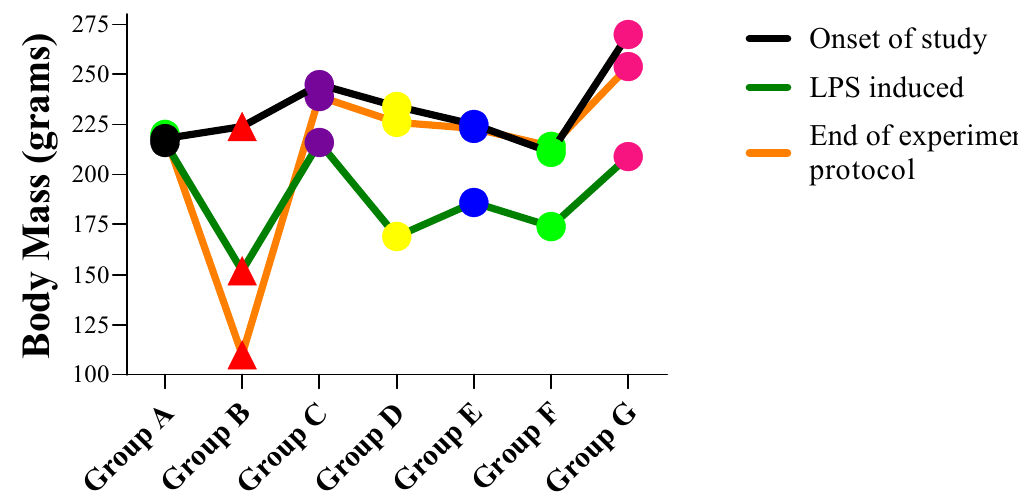
Figure 1. The trend of body mass of Wistar Rats during the experimental protocol.